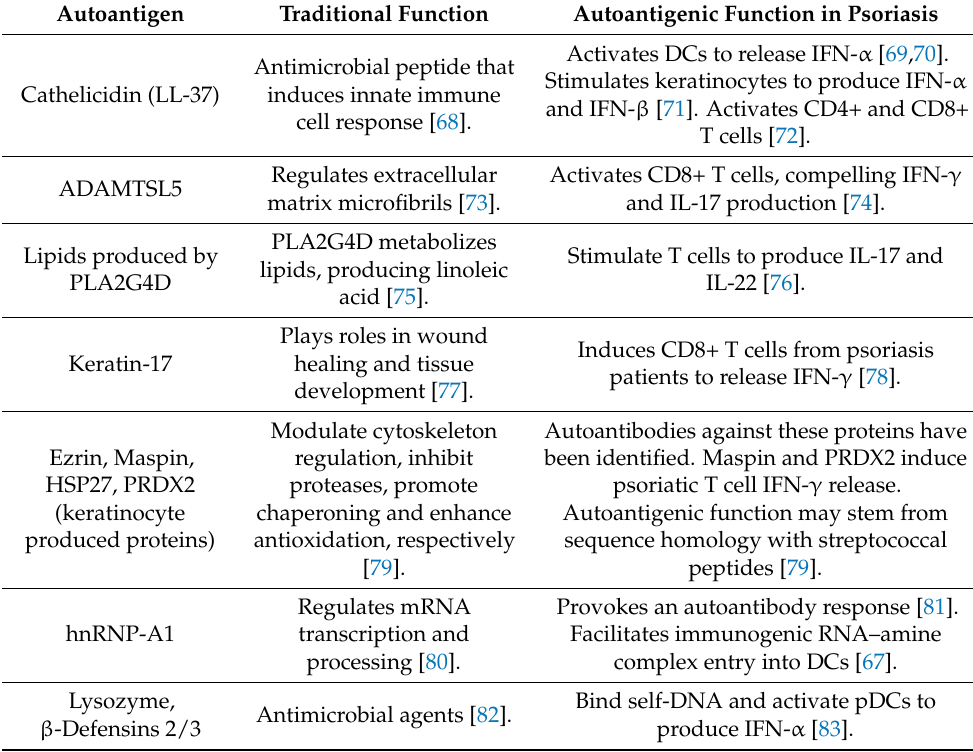
Table 1. Autoantigens found in the pathogenesis of